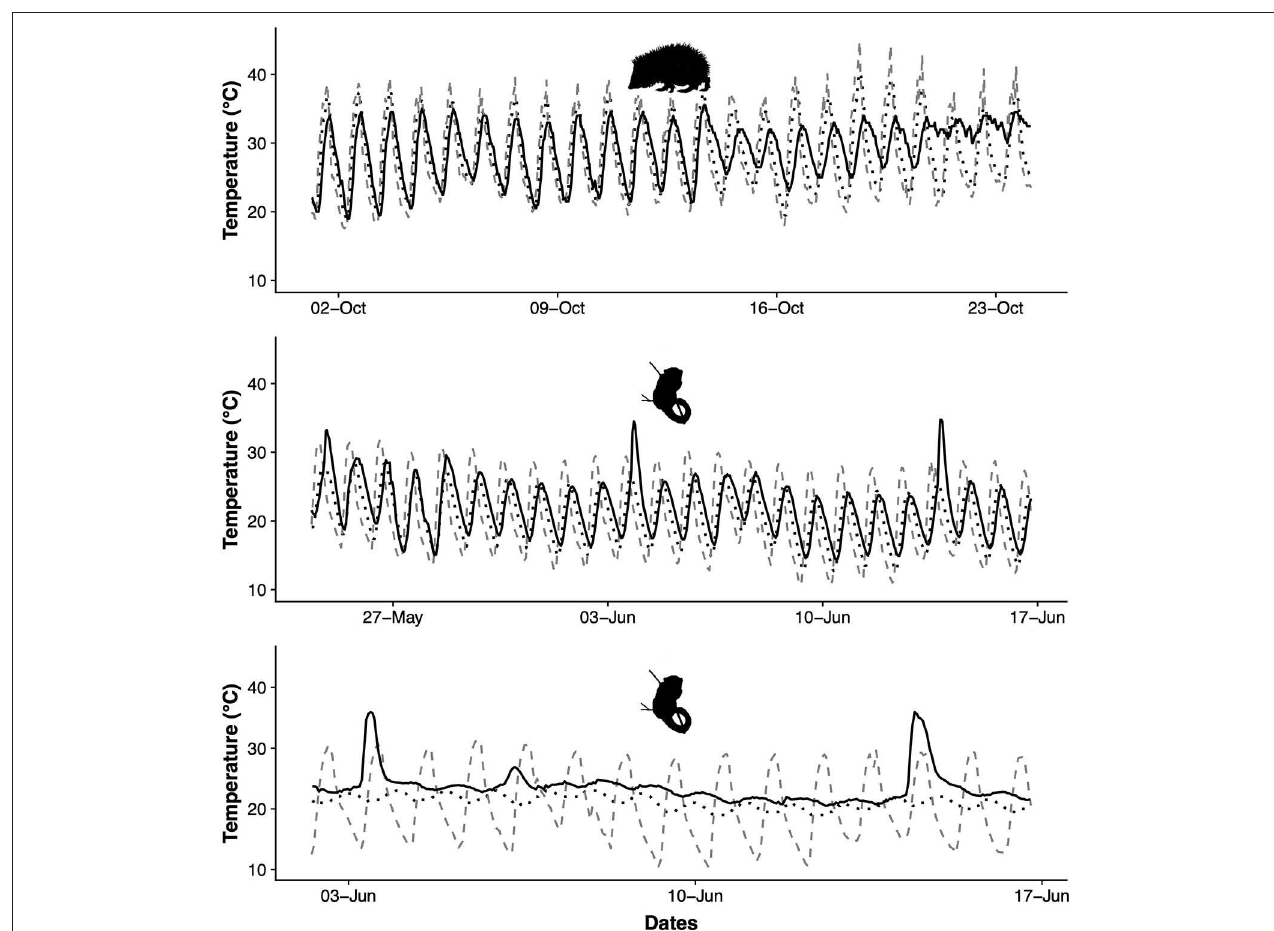
FIGURE 2 | Top panel: Body temperature (black), ambient temperature (dashed gray) and temperature from a nearby nest site (dotted black) of a free ranging greater hedgehog tenrec ( Setifer setosus ) during the Austral winter (dry season). Redrawn from Lovegrove et al. (2014a) and Levesque et al. (2014). Middle and lower panel: Body temperature (black), ambient temperature (dashed gray) and tree-hole temperature (dotted black) of a free ranging fat-tailed dwarf lemur ( Cheirogaleus medius ) during the Austral winter (dry season) in a poorly insulated (middle) or moderately well insulated (lower panel)